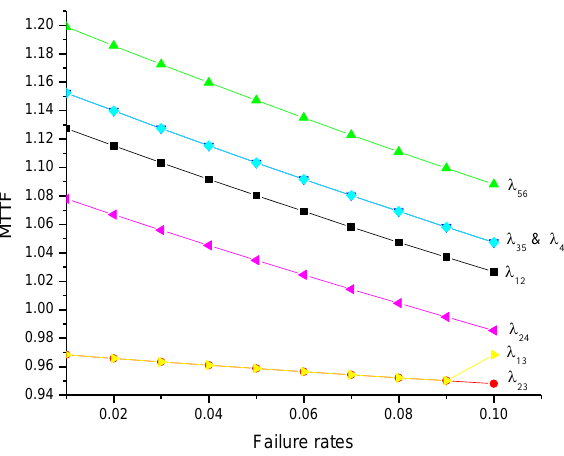
Figure 3. MTTF of the communication network.